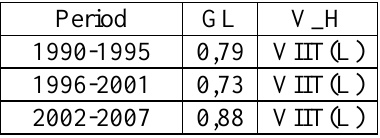
Table 6: Type of IIT (3-period)